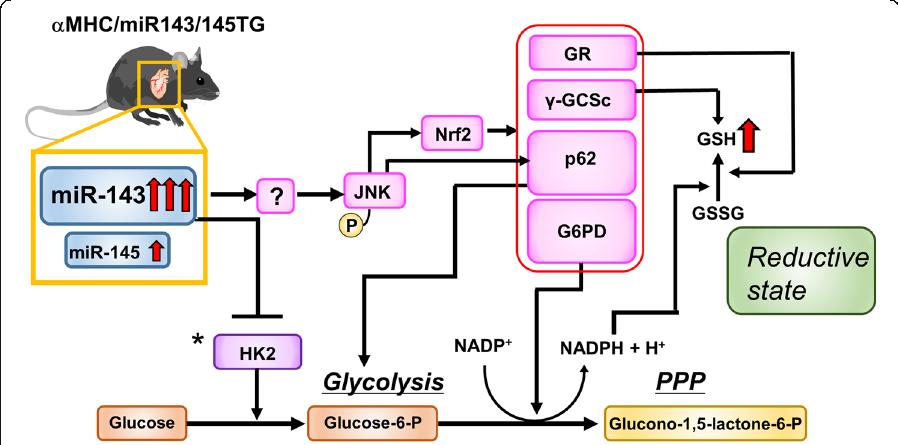
Fig. 6 Schematic depiction of the signaling cascade in α MHC/miR-143/145TG mice. A hypothetical signaling model for a reductive state in α MHC/miR-143/145TG mice is shown. Our data indicate that the overexpression of miR-143 plays a pivotal role in the pathogenesis of the α MHC/miR-143/145TG phenotype, but the key targets for miR-143 triggering this process have not been identified and are shown with a question mark. *: Although the expression of HK2 was suppressed in transgenic hearts, in vitro HK activity was comparable in the L9 and NTG mouse hearts. Since the expression levels of GR, γ -GCSC, p62 and G6PD are controlled by Nrf2, these four molecules are surrounded by a red box. A detailed explanation is given in the Discussion